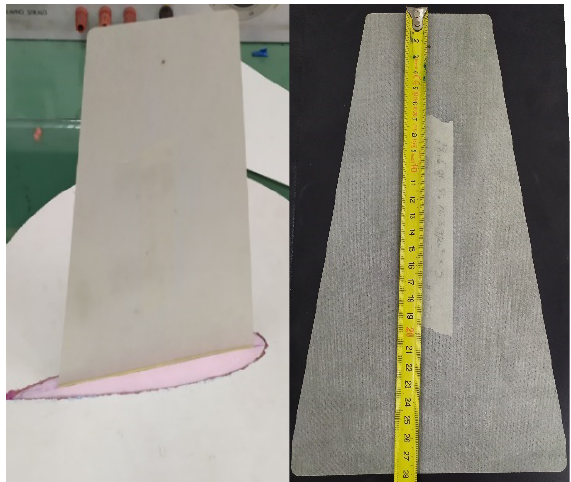
Figure 14. E-glass tapered plate for wind tunnel flutter